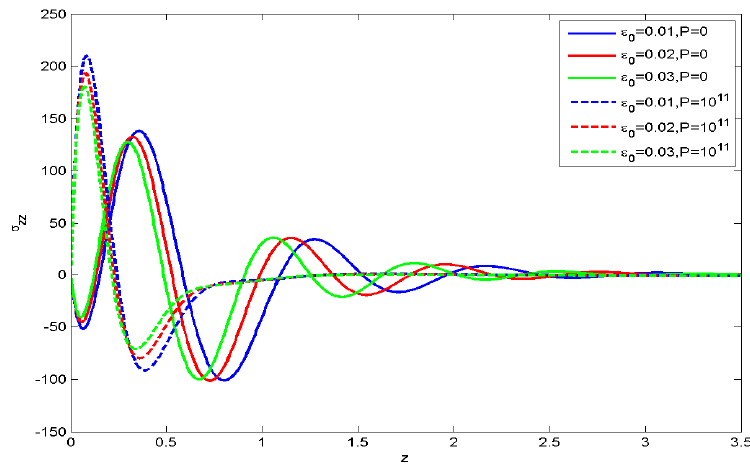
Figure 13. Normal stress σ zz concerning z with electric field ε 0